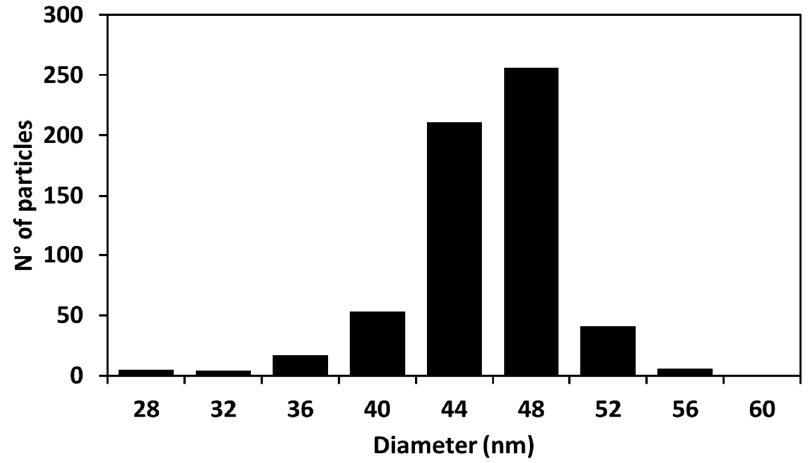
Figure 2. Histogram of the Cur-AgNPs diameters obtained from analyzing the TEM images with ImageJ software (the size of 605 particles was measured).